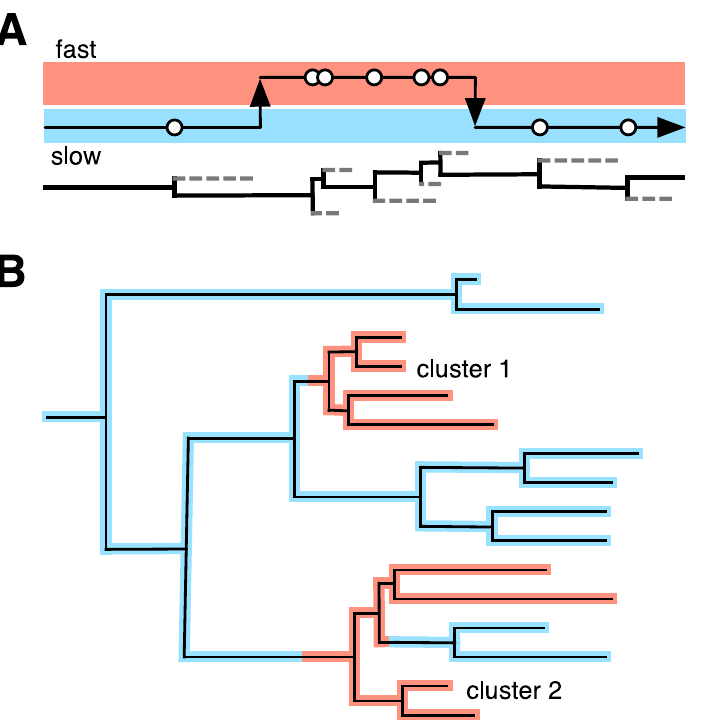
Fig 1. Schematic diagram of a model-based genetic clustering method. The rate of branchingevents (approximating transmission events) evolves accordingto a Markov-modulatedPoissonprocess (MMPP). (A) A lineageswitches betweentwo states (fast and slow) that control the rates that branchingevents occur. (B) When rate shifts are mapped to the tree, we can identify clusters of high transmissionrates (red).